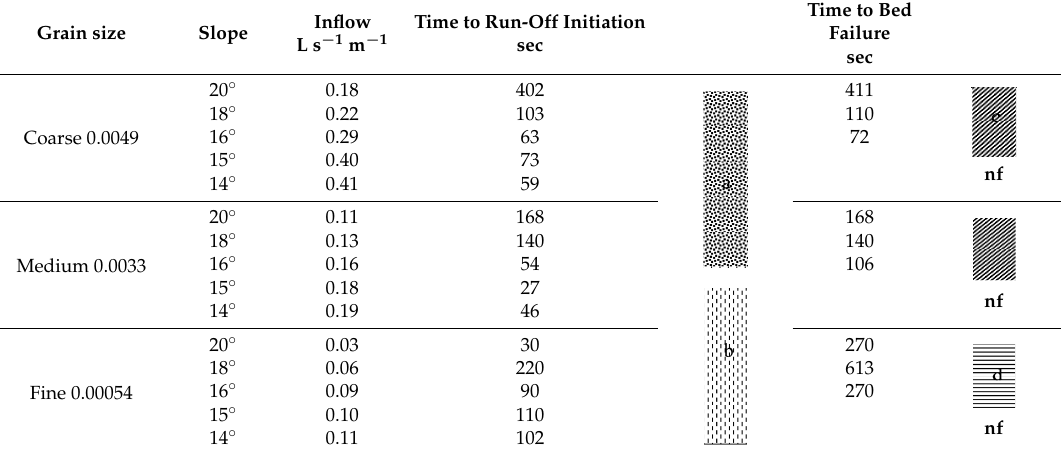
Table 2. Observed time to overland flow and bed failure, overland flow type and failure mode in flume experiments for three types of bed material and for different bed slope angles: (a) saturation overland flow; (b) Hortonian overland flow; (c) slow continuous bed failure; (d) rapid failure; nf: no failure. Grain size Slope